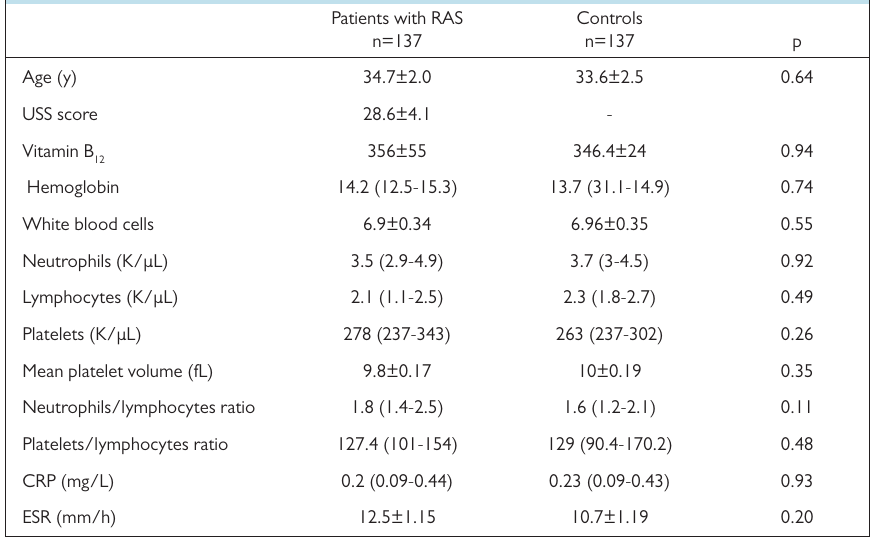
Table 1. Clinical characteristics and laboratory parameters of study